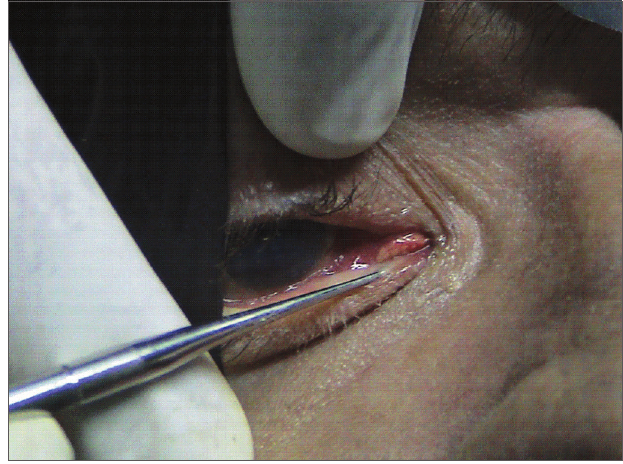
Figura 1. Introdução do dilatador do ponto lacrimal pelo canalículo inferior.